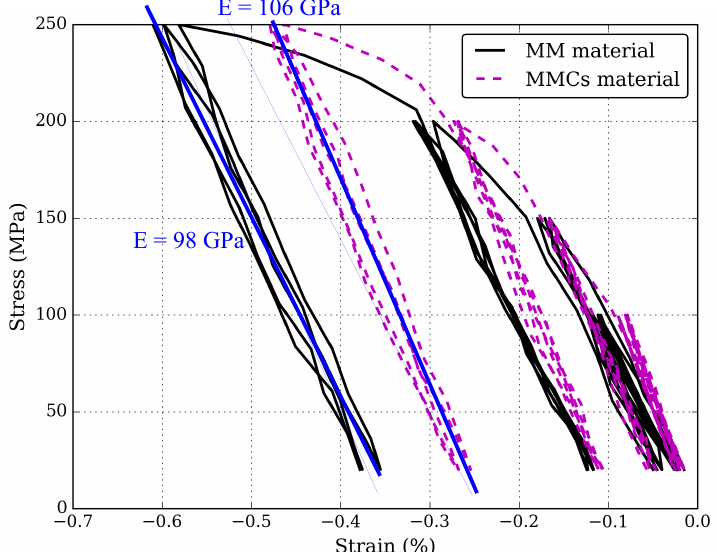
Figure 6. Plots describing the compressive stress-strain (E zz ) curve of MM (in black) and MMCs (in dashed magenta)